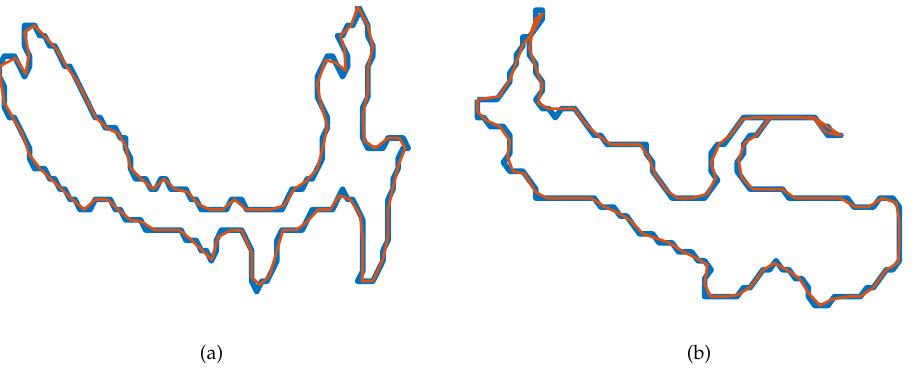
Figure 7. Border obtained the Moore-Neighbour tracing algorithm (blue) and the reparametrization of the border to 100 border points (red): ( a ) Application for the first image; ( b ) application for the second image.